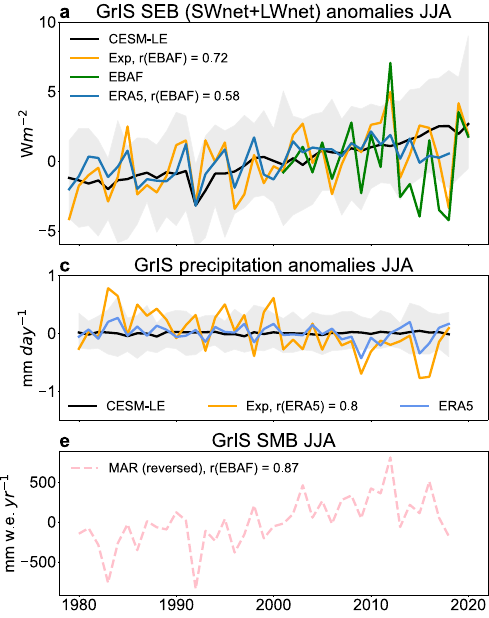
Fig. 2 | The critical role of circulation in determining observed GrIS surface mass/energybalanceover1980 – 2018assimulatedbythenudgingexperiment. Comparisons between the Greenland ice sheet (GrIS) spatial-averaged surface energy balance (SEB) anomaly time series in ERA5 (blue), EBAF satellite product (green, Methods), the nudging experiment (Exp, orange) and the CESM-LE (grey shading and black line for the ensemble mean) for a summer (June – July – August, JJA) and b for annual means. Comparison between ERA5 (blue), the nudging